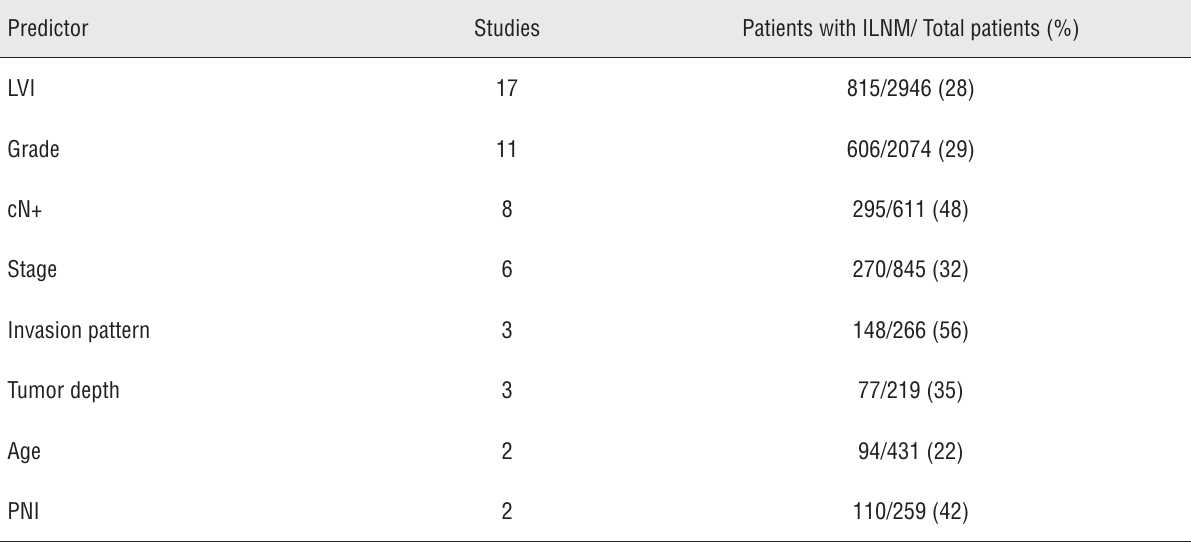
Table 2 - Quantity of clinical/pathological markers found to be significant amongst all studies. Quantity of clinical/pathological markers: Predictor Studies Patients with ILNM/ Total patients (%) LVI 17 815/2946 (28) Grade